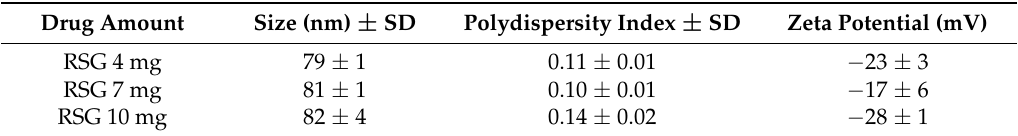
Table 3. Size, PDI, and zeta potential of nanoparticles prepared by nanoprecipitation technique using